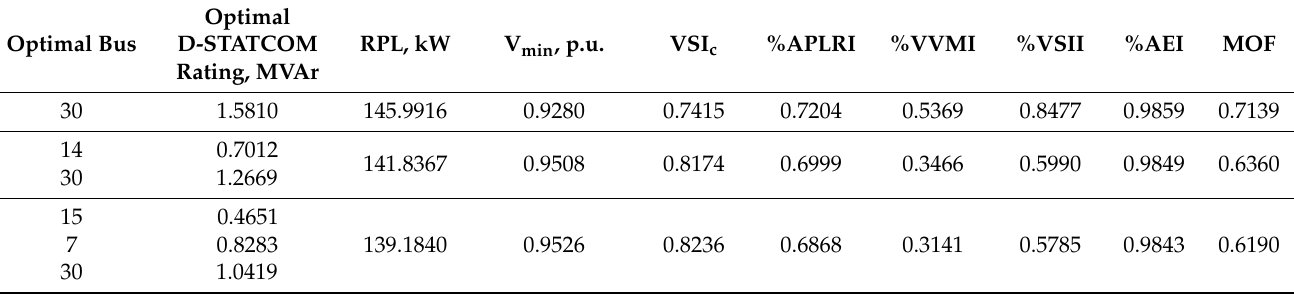
Table 4. Comparison of results for OADS using SPBO algorithm for 33-bus PDN.